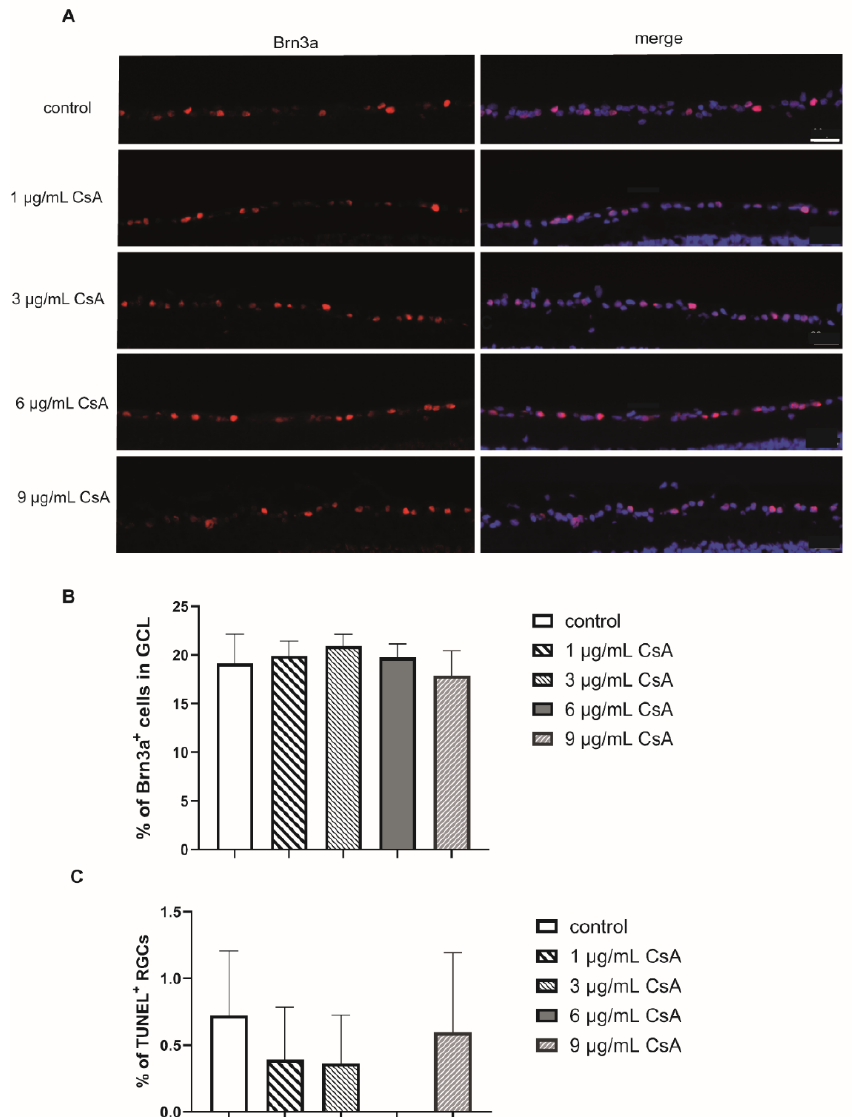
Figure 1. Biocompatibility of the different CsA concentrations. ( A ) Representative pictures of the Brn3a in each group after 48 h. Scale bar indicates 50 µ m. ( B ) Quantification of Brn3a + retinal ganglion cells (RGCs) labeld in red and cell nuclei (DAPI) in puple. The bar graph represents the percentage of these cells in the ganglion cell layer (GCL). ( C ) The percentage of TUNEL + RGCs after 48 h of cultivation. Sections were double stained for DAPI and Brn3a. Bars and error bars indicate mean + SEM. (controls n = 10; all CsA groups n =